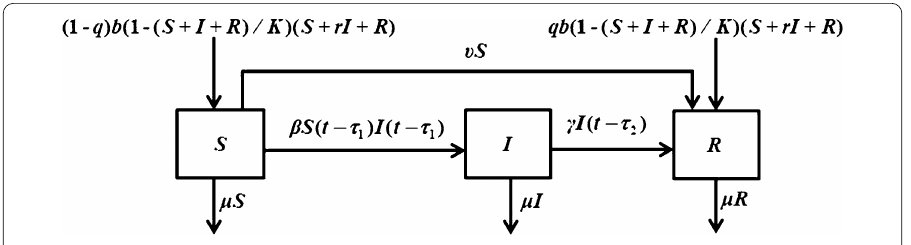
Figure 1 The flow diagram of system